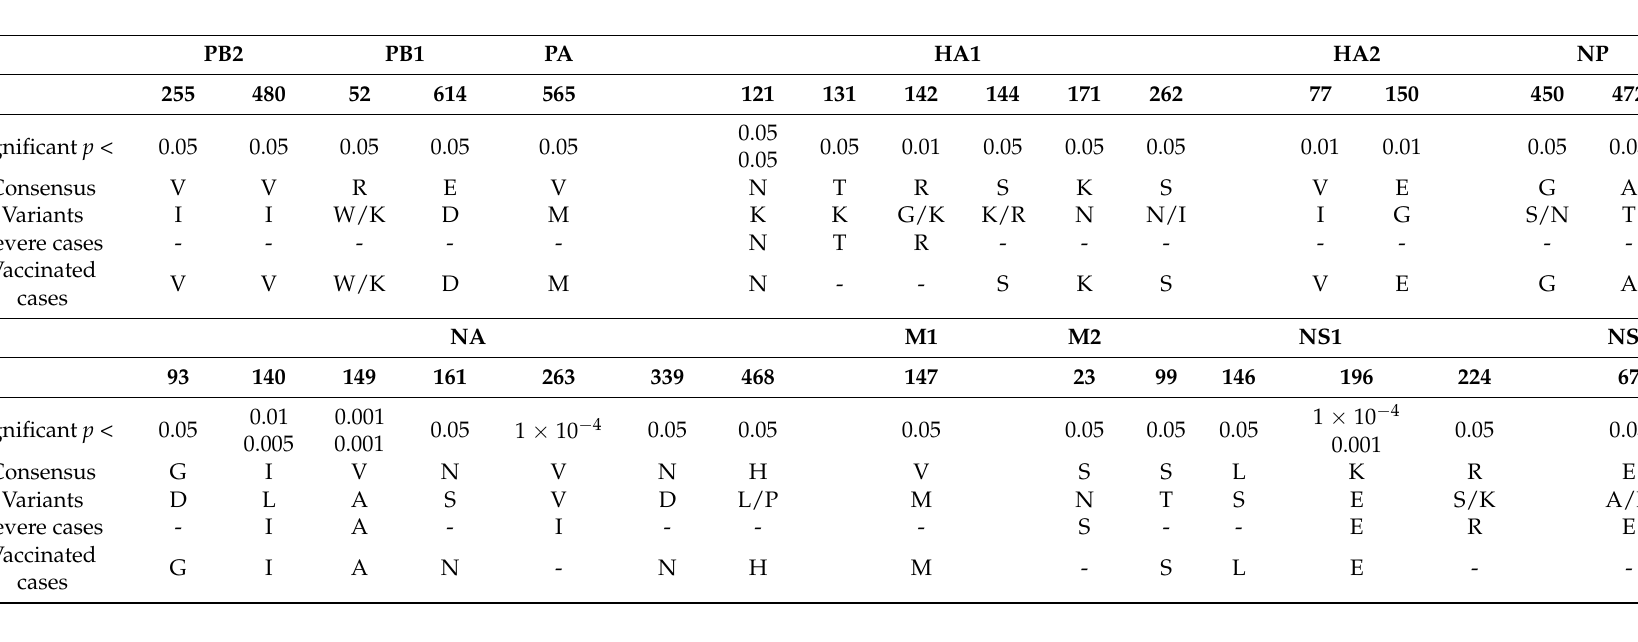
Table 2. Substitutions significantly distinguishing mild from severe cases, and vaccinated from non-vaccinated cases. ( a ) The amino acid of each significant position is indicated for the seasonal consensus, observed variants and, when significant, variants associated with a group. Cases where, for a given position, no amino acid was significantly associated with a group are designated by dashes. ( b ) NA V263I and NS1 K196E occurrences in mild and severe